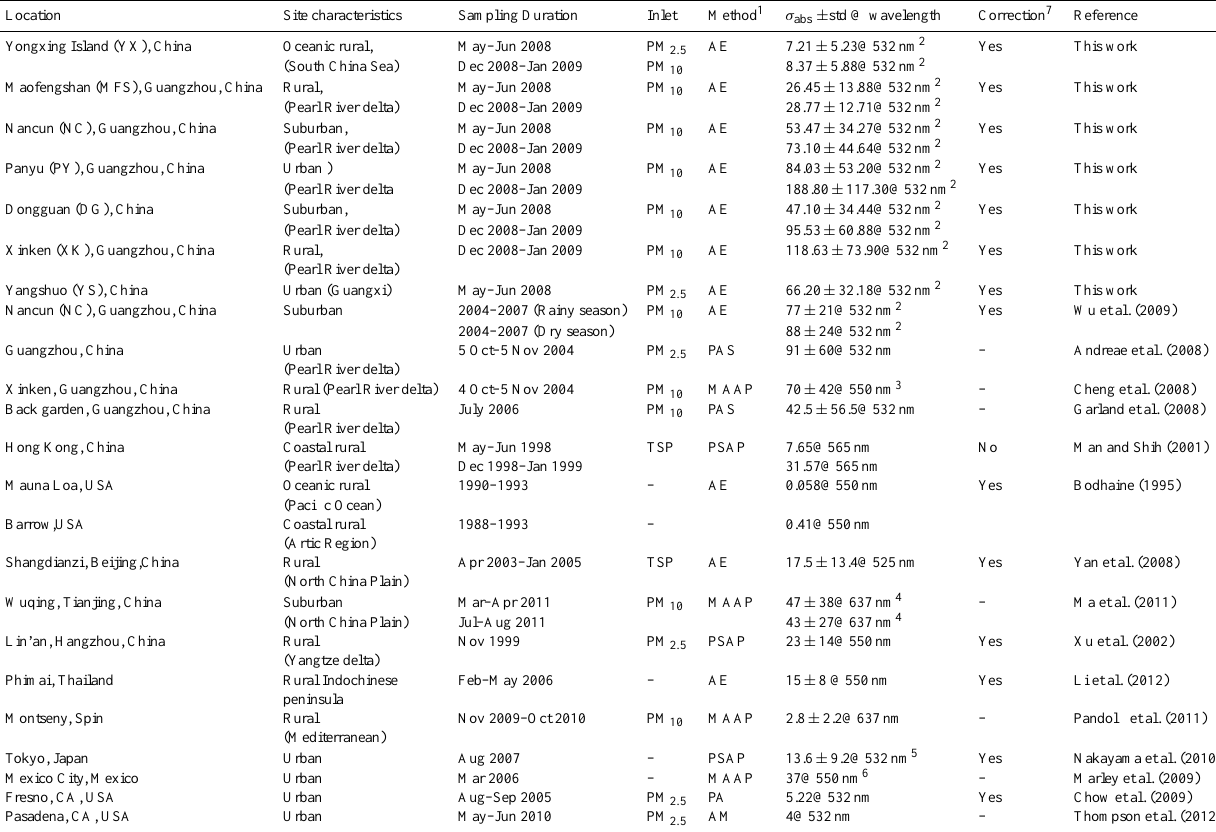
Table 3. Comparison of light-absorption measurements (Mm − 1 ) at different locations in the world.